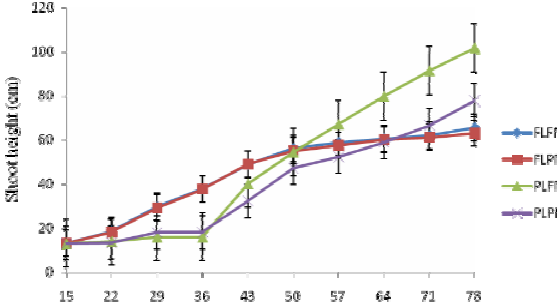
Fig. 1. Effect of light and nutrient stress on the shoot height